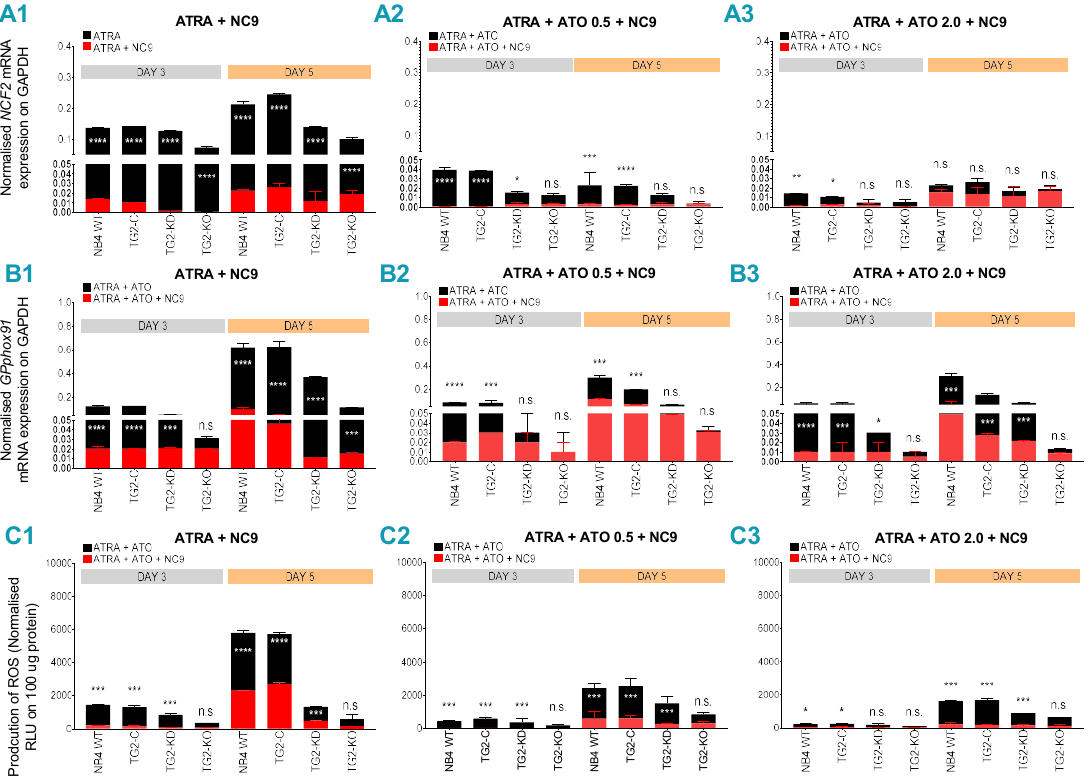
Figure 4. The TG2 inhibitor NC9 diminishes the capability of ATRA + ATO-di ff erentiated NB4 WT cell lines for ROS production. ( A1 – A3 ) Relative mRNA expressions of NCF-2 / P67PHOX and GP91PHOX ( B1 – B3 ) were measured in NB4 WT, TG2-C, TG2-KD and TG2-KO cells treated with ATRA + NC9, with ATRA + ATO 0.5 µ M + NC9 and with ATRA + ATO 2.0 µ M + NC9 at the indicated time